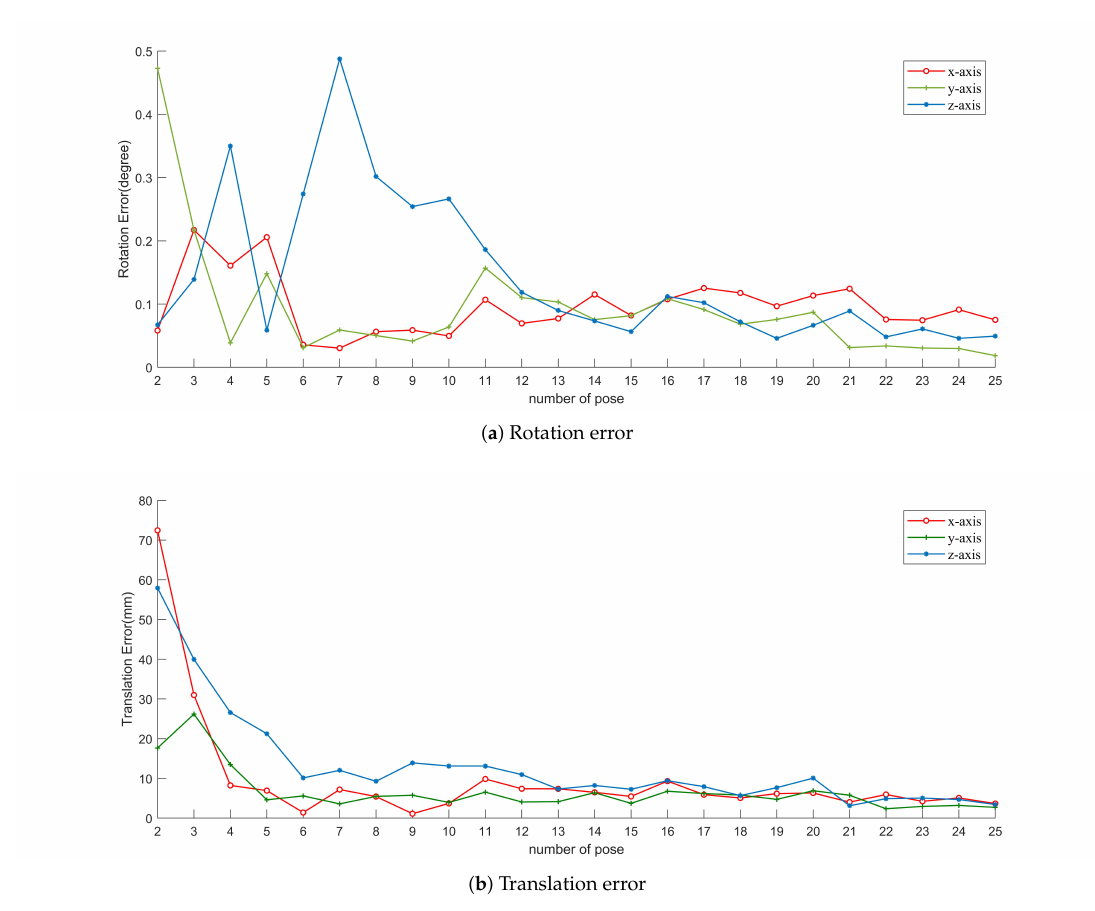
Figure 13. Errors for real data with respect to the number of poses we used. Table 4. Calibration result obtained with 25